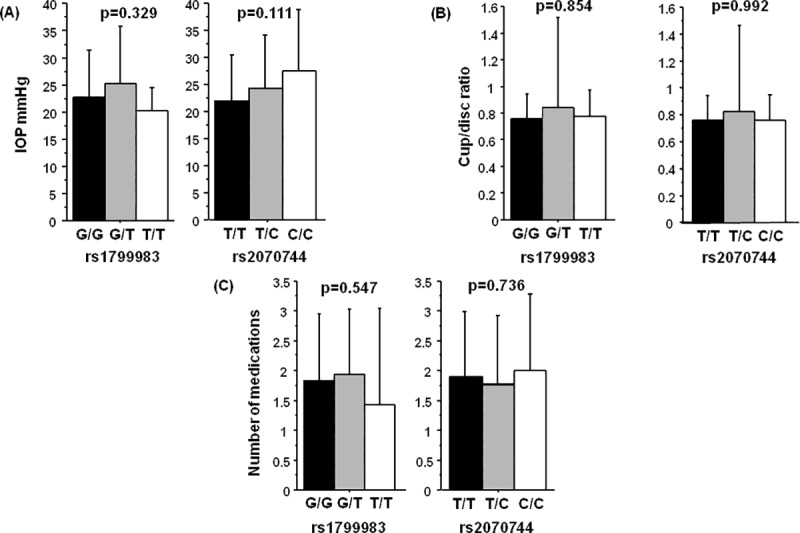
Genotype effect of rs1799983 and rs2070744 on glaucoma specific clinical indices in PAOG cases.(A) intraocular pressure (IOP), (B) cup/disc ratio and (C) number of antiglaucoma medications. Note: p-value calculated by Kruskal-Wallis test.